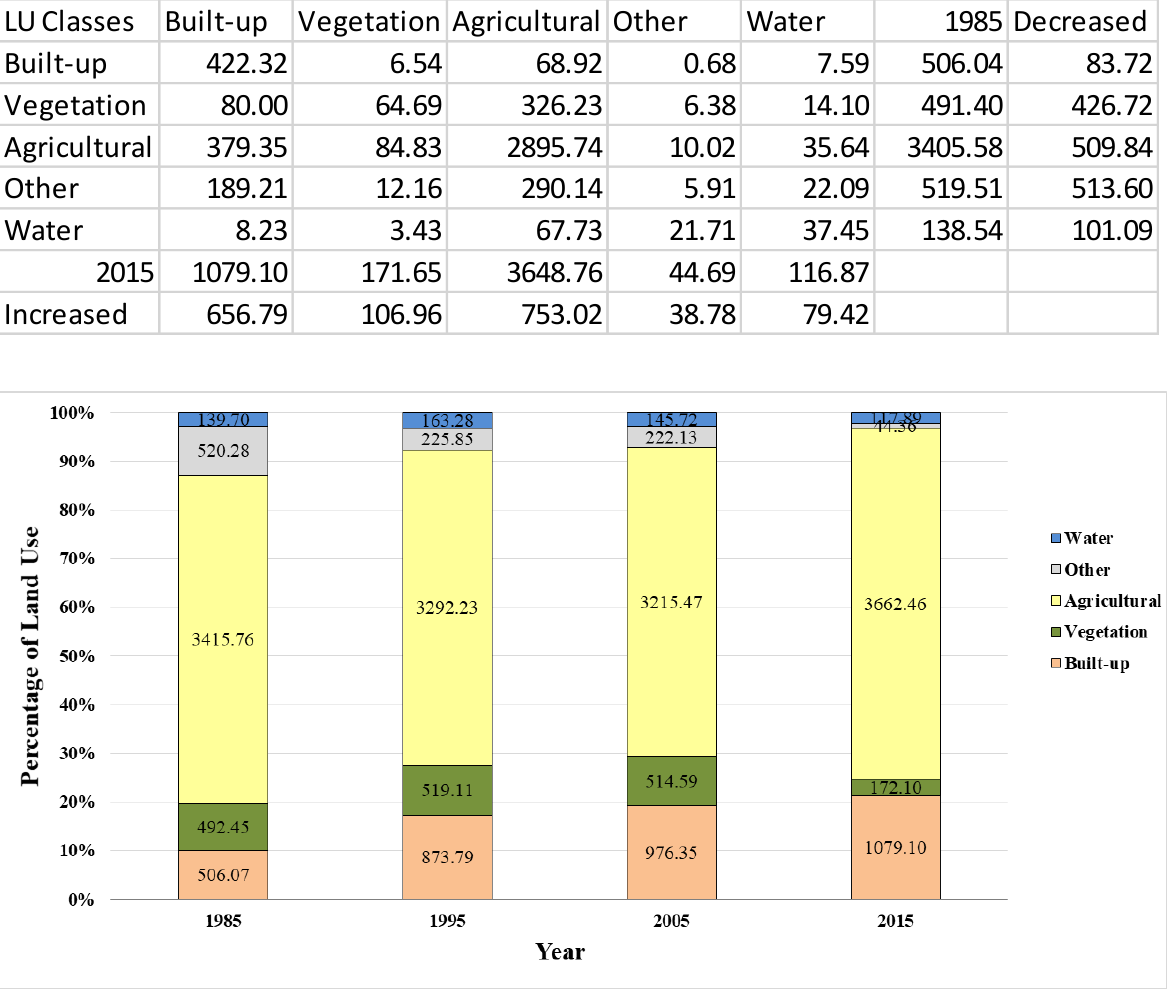
Table 2. Change Matrix for Land use classes in 11 smart cities of Uttar Pradesh for 1985 to 2015.